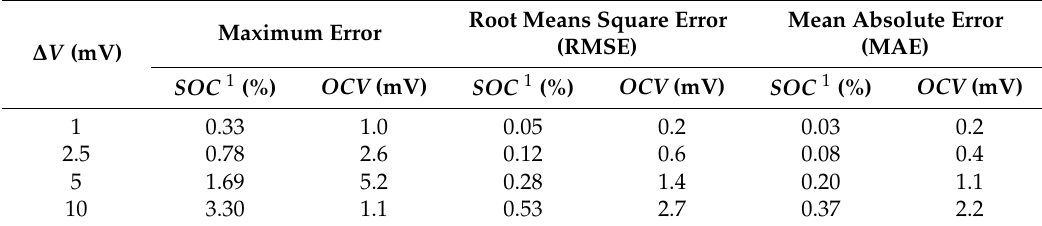
Table 5. Statistical error analysis at different values of voltage sensors.